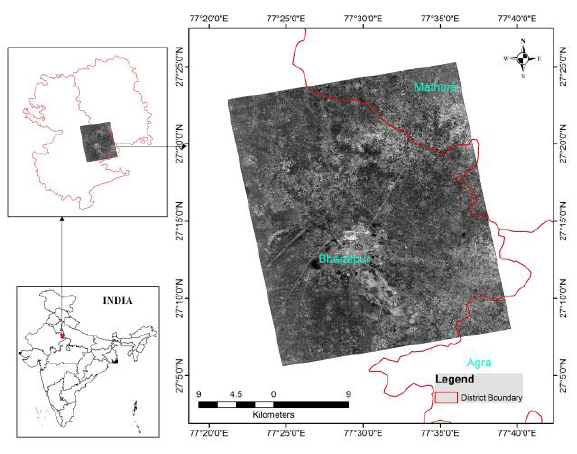
Figure 1. The location of study area